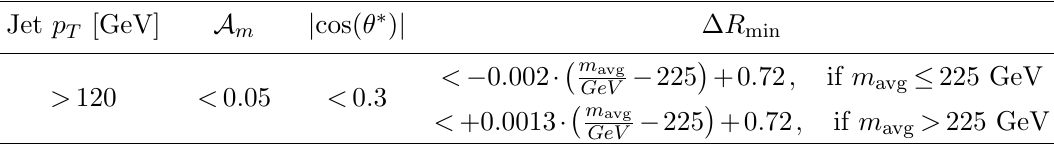
Table 3. The list of selection criteria with the direction of the cut for the ATLAS di-jet search [50].